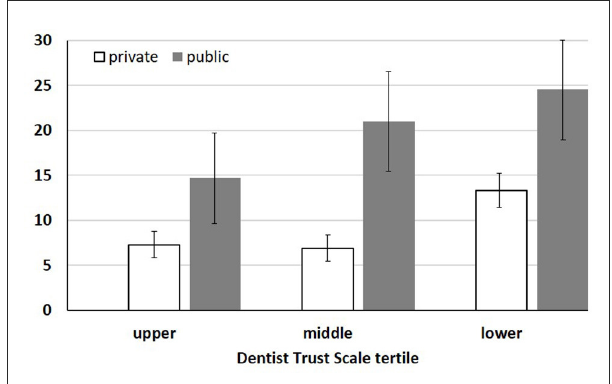
FIGURE1 Percentage of ‘poor’ to ‘very poor’ SRDH (% ± SE).